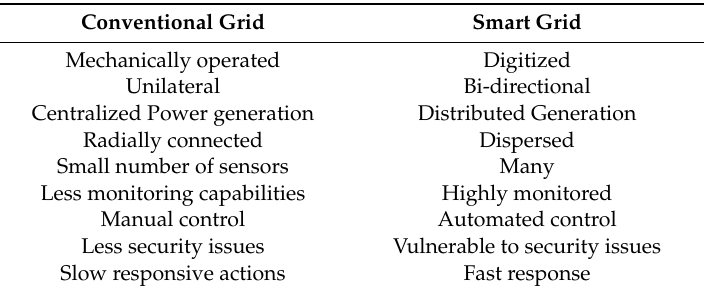
Table 1. Conventional grid versus smart grid [15].